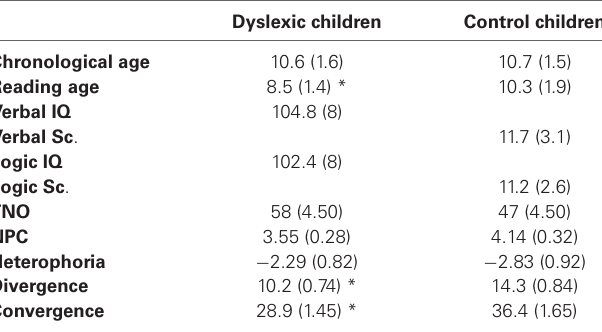
Table 1 | Clinical characteristic of the two groups of children examined (dyslexic and control children)